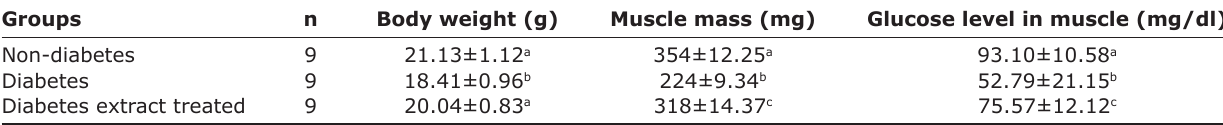
Table-1: The characteristic comparison between groups.